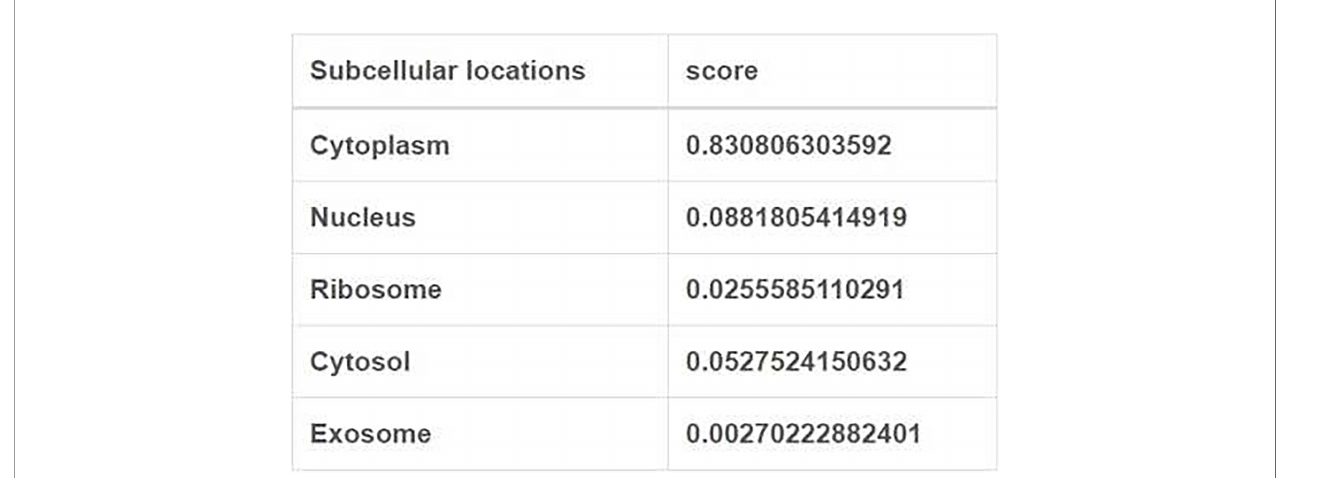
FIGURE 3 | Subcellular localization of LINC00641 (from lnlocator